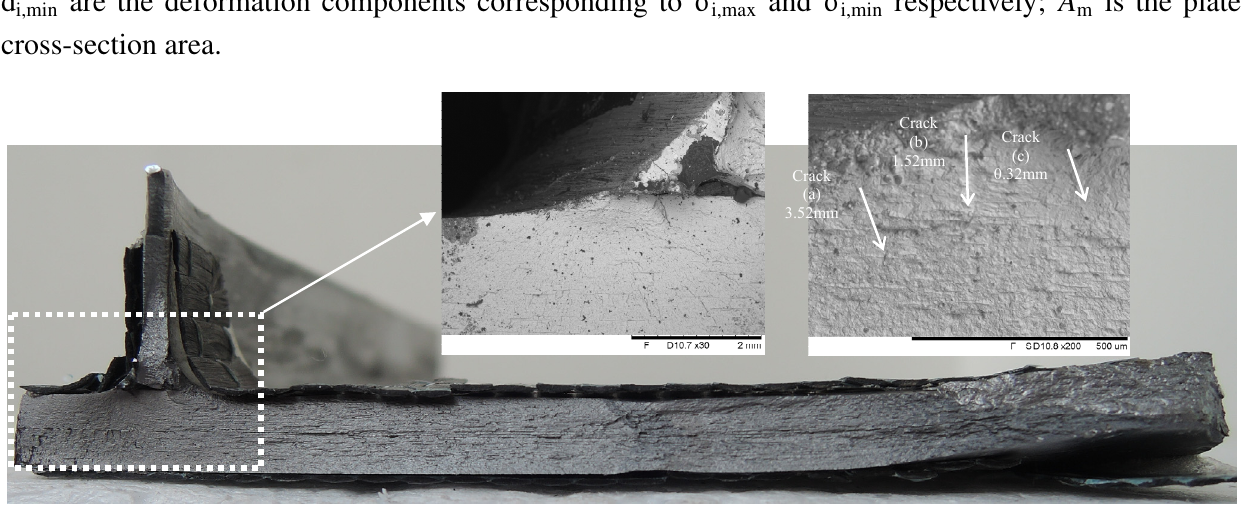
Figure 4. Typical fracture surface at weld toe.